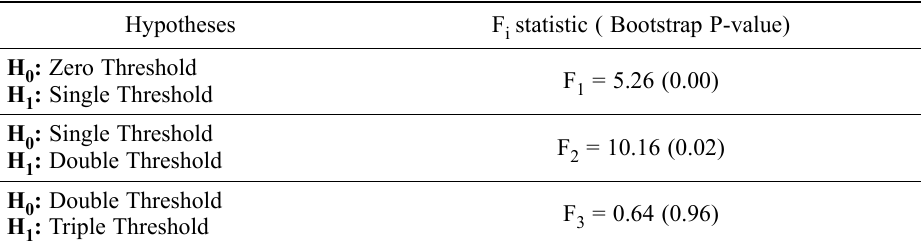
Table 4. Likelihood ratio Test for threshold